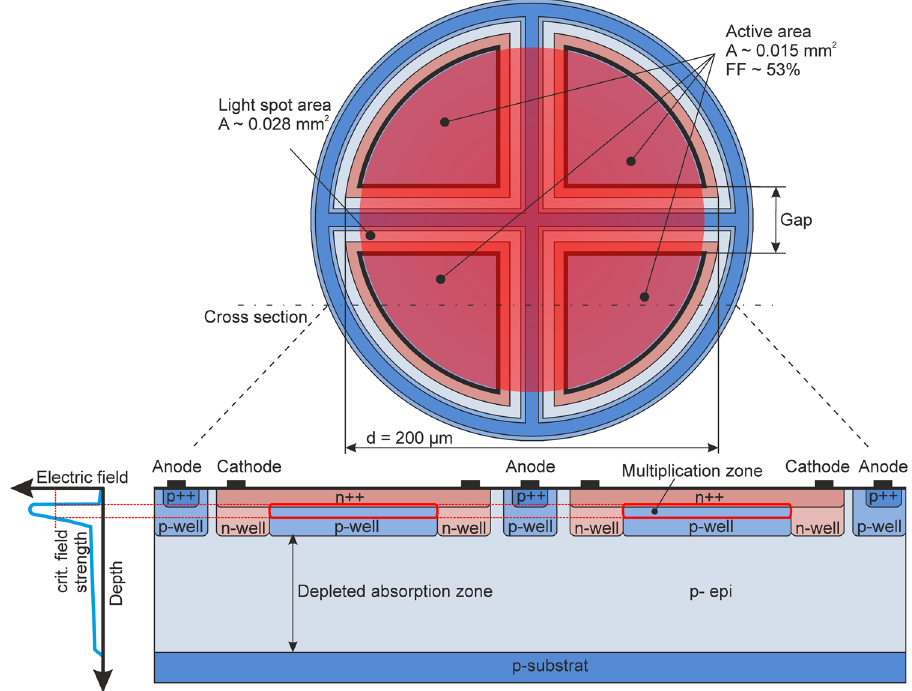
Figure 2. Top view, schematic electric field distribution and cross section of SPAD with separate absorption and multiplication zones (not to